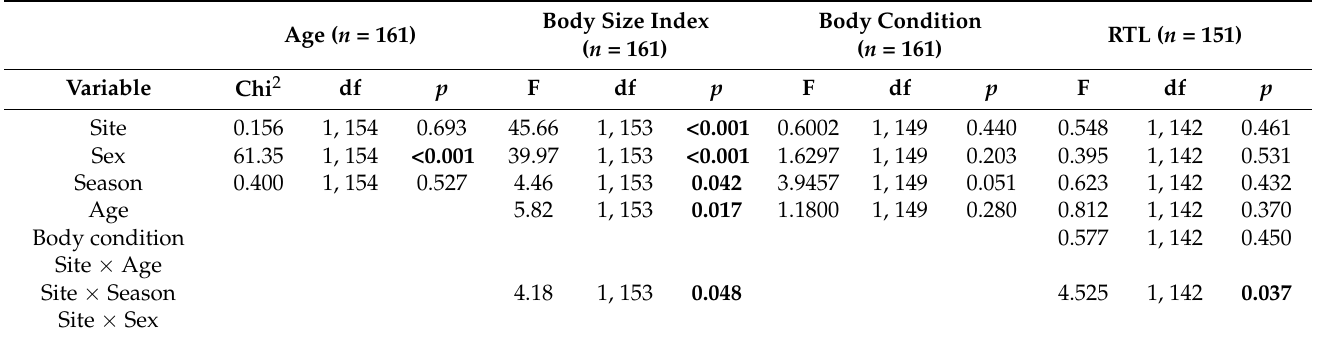
Table 1. Result of statistical analyses of morphological and genomic parameters between urban and forest birds and between seasons (winter and